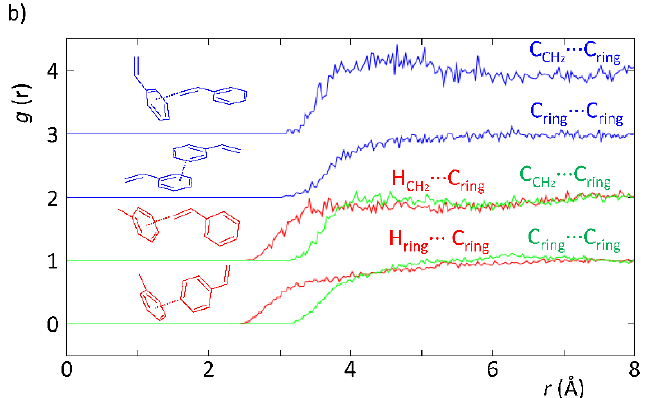
Figure 3. Partial radial distribution functions from EPSR simulation of experimental data obtained with SANDALS data from experiment RB1600022 on the styrene–acetonitrile ( a ) and styrene–toluene ( b ) systems replicating the ratios used in a catalytic experiment.